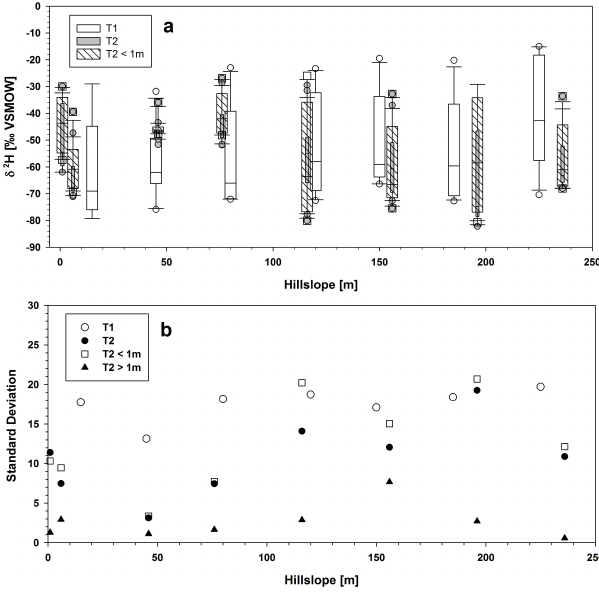
Fig. 6. Boxplots (a) and standard deviation (b) of the deuterium data of the total vertical depth profiles and for a direct comparison of the profiles along both study transects the upper 1m of the T2 profiles.